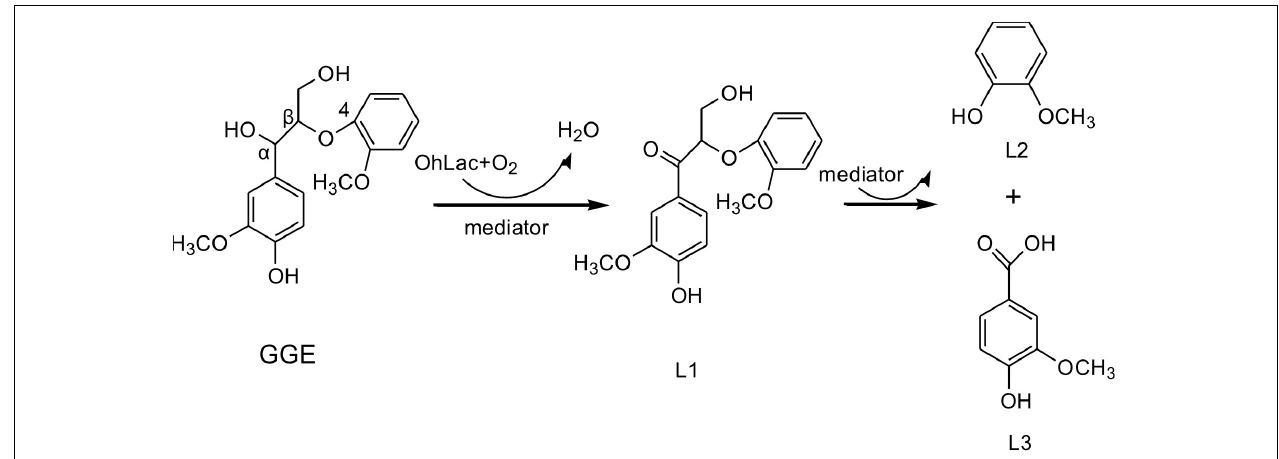
FIGURE 8 | The presumed cleavage process of lignin model compound GGE degraded by